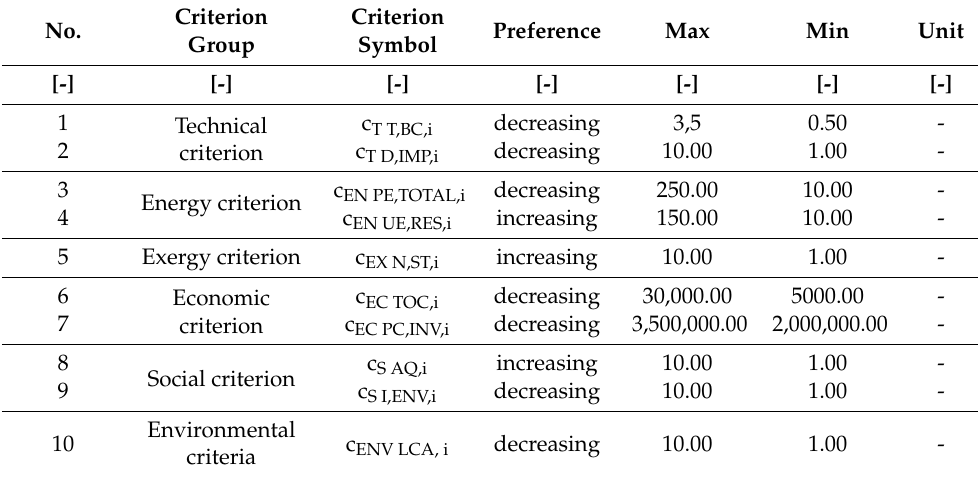
Table 7 lists the maximum permissible numerical values of the indicators, along with the direction of preferences of a given value. Table 7. Permissible numerical values of indicators for the adopted evaluation